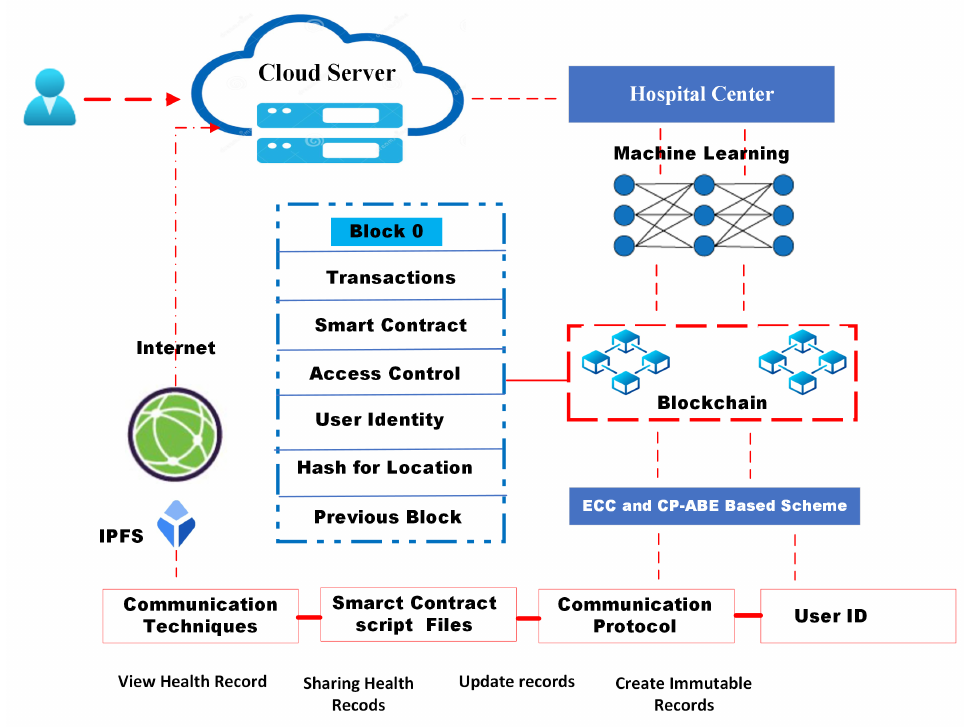
Figure 2. Secure machine-learning-based blockchain model for